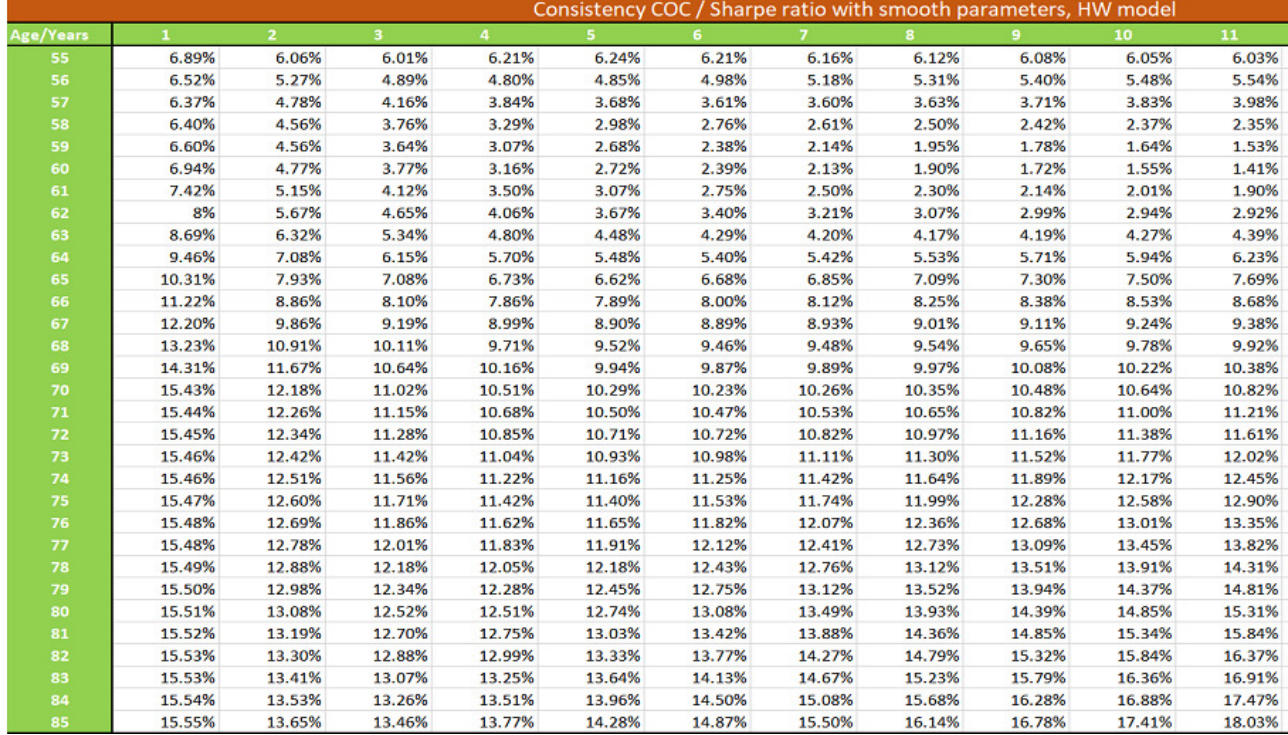
Figure A8. Consistency between Sharpe and Cost of Capital method with smooth parameters, HW